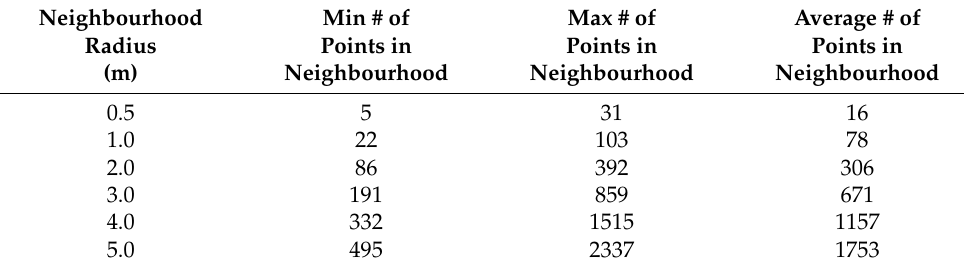
Table 2. Neighbourhood point